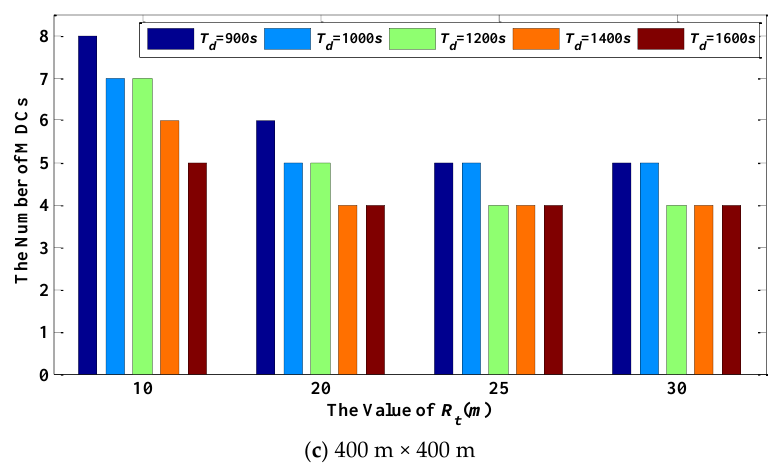
Figure 18. The number of MDCs in the network with different sizes.